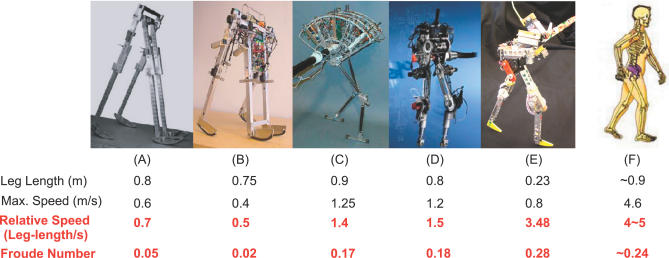
Relative Leg-Length and Maximum Relative Speed of Various Planar Biped Robots(A) A copy of McGeer's planar passive biped robot walking down a slope [77].(B) “Mike,” similar to McGeer's robot, but equipped with pneumatic actuators at its hip joints. Thus it can walk half passively on level ground [77].(C) “Spring Flamingo,” a powered planar biped robot with actuated ankle joints [78].(D) Rabbit, a powered biped with four degrees of freedom and pointed feet [79].(E) RunBot.(F) The world record for the fastest human's walking speed [80,81].